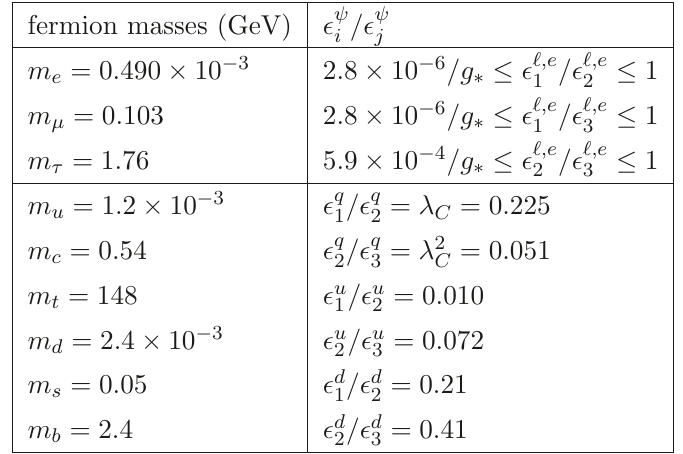
Table 1 . In the left column we show the values of the running fermion masses at µ = 1 TeV [12]. In the right column are the corresponding ratios of PC parameters, assuming for definiteness a strict equality m ψ = g ∗ ǫ ψ L ǫ ψ R v/ √ 2 for each SM fermion ψ , and taking λ C = 0 . 225 for the Cabibbo i i i angle. Of course these ratios are sensitive to variations in the unknown order-one parameters c